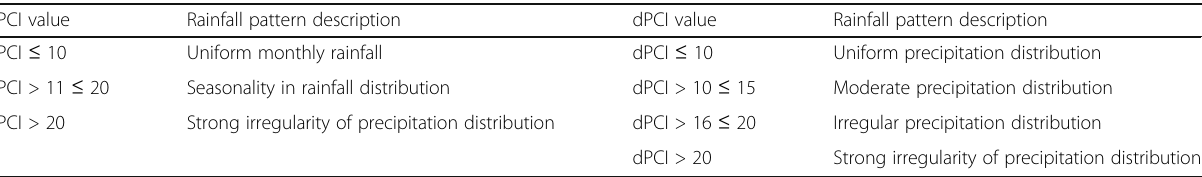
Table 1 The PCI and dPCI range and classification Rainfall pattern description dPCI value Rainfall pattern description dPCI ≤ 10 Uniform precipitation